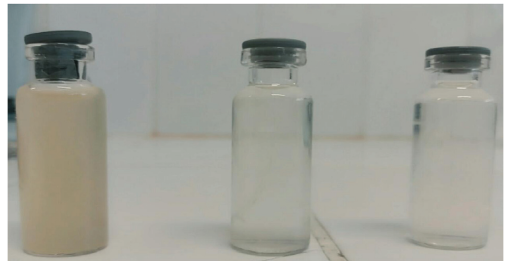
Figure 4: Visual appearance of raw effluent and RS (1) and CS (2)